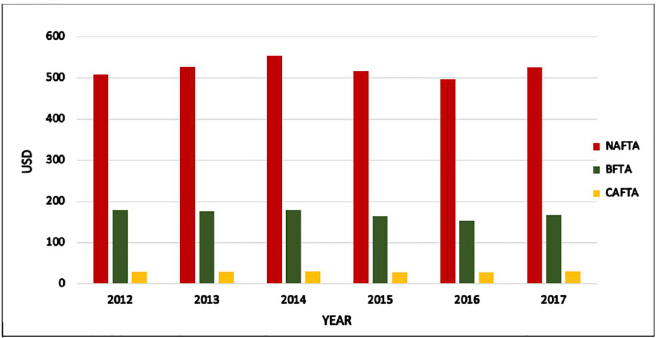
Fig 1. Total exports from the United States to all FTAs (NAFTA, BFTA, and CAFTA-DR) from 2012 to 2017.